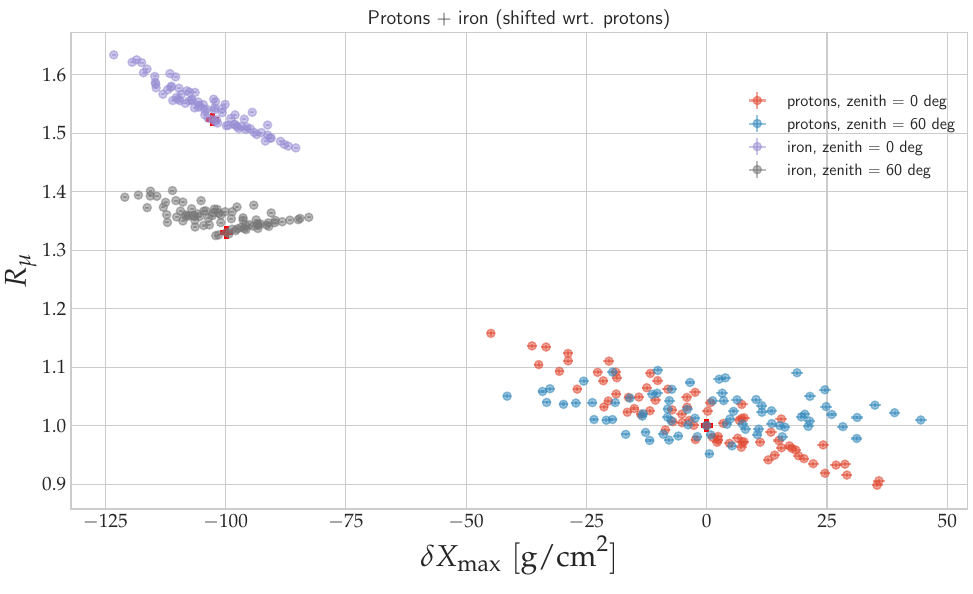
Figure 9. Mean muon rescaling R µ and mean shift of X max for proton and iron primaries shown in both cases with respect to unmodified simulations for proton. Results are shown for two zenith angles, in each case the reference is taken at the corresponding zenith angle; each point corresponds to a particular combination of f sigma